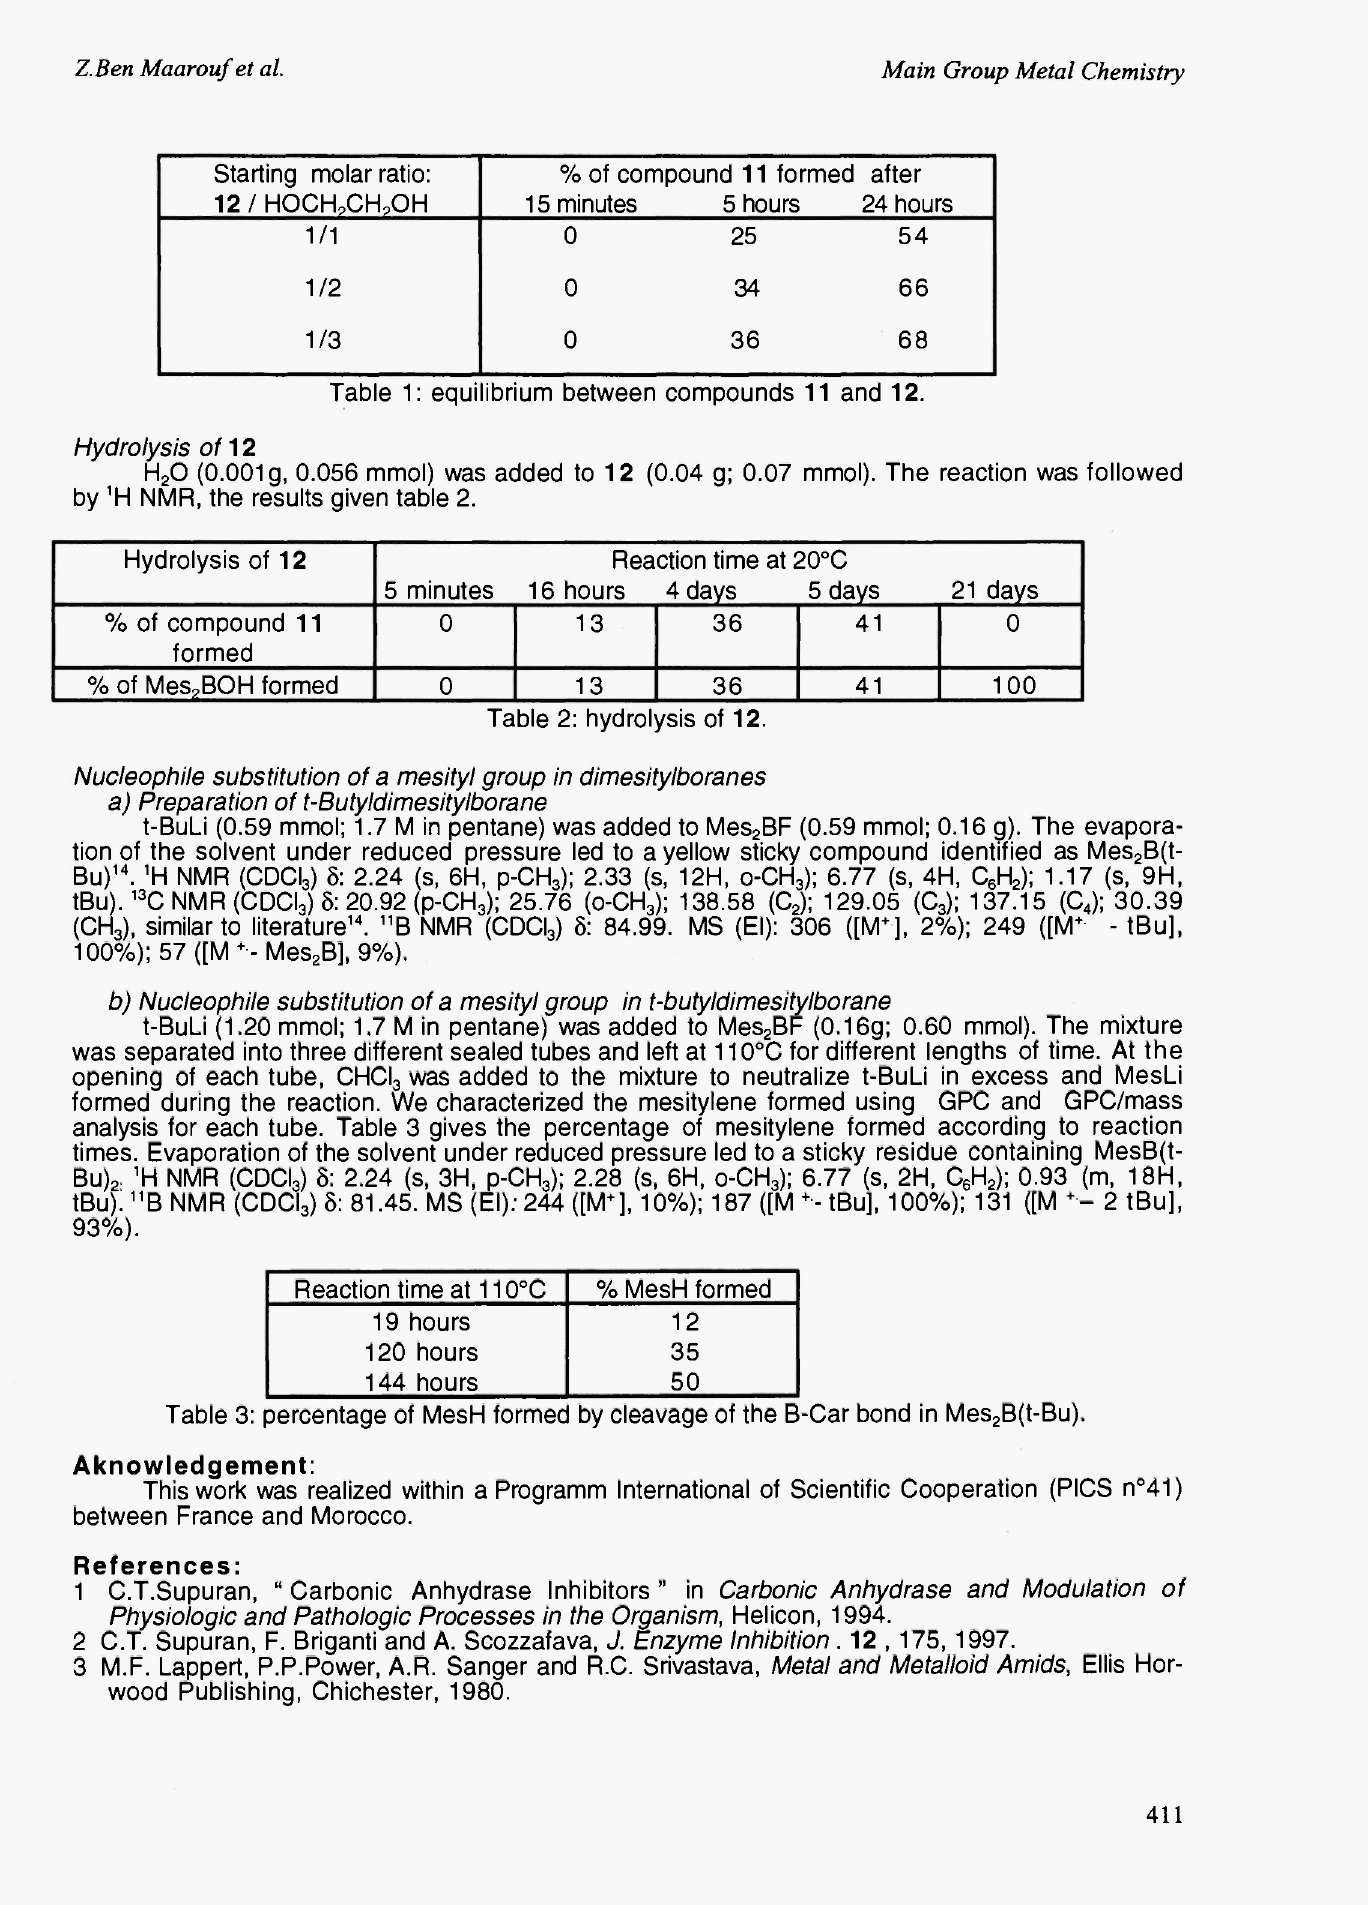
Table 3: percentage of MesH formed by cleavage of the B-Car bond in Mes 2